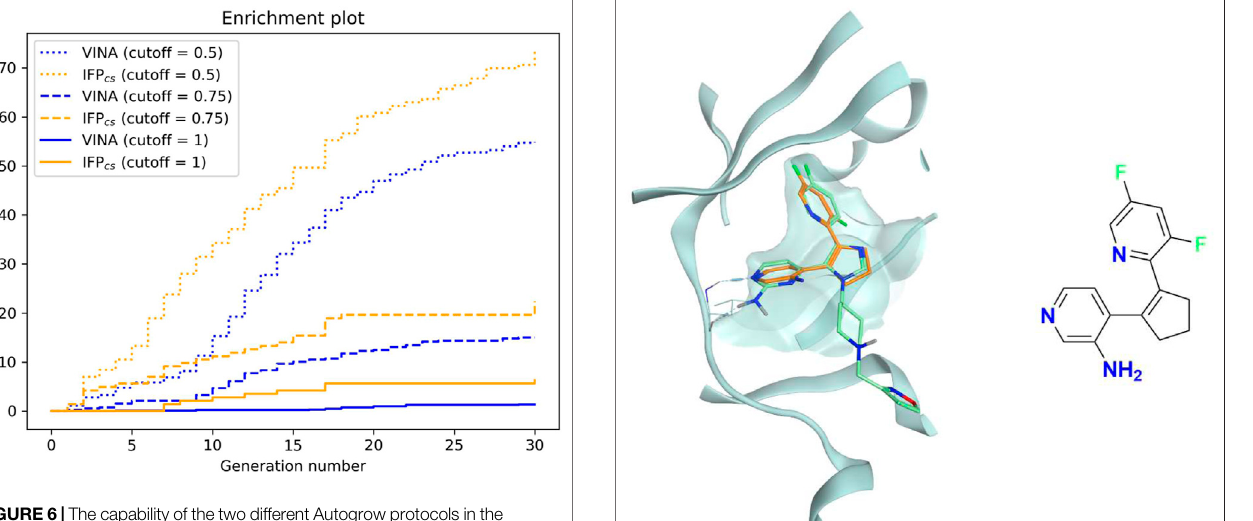
FIGURE 6 | The capability of the two different Autogrow protocols in the benchmark de novo run to produce compounds that have a high degree of similarityconcerningshapeandelectrostaticpropertiestothecrystallographic ligands, chosen as reference. For each generation, the percentage of compounds within the total population whose ET combo exceeds a de fi ned threshold value is reported. Three different cutoff values are reported: 0.50, 0.75, and 1.00, respectively.